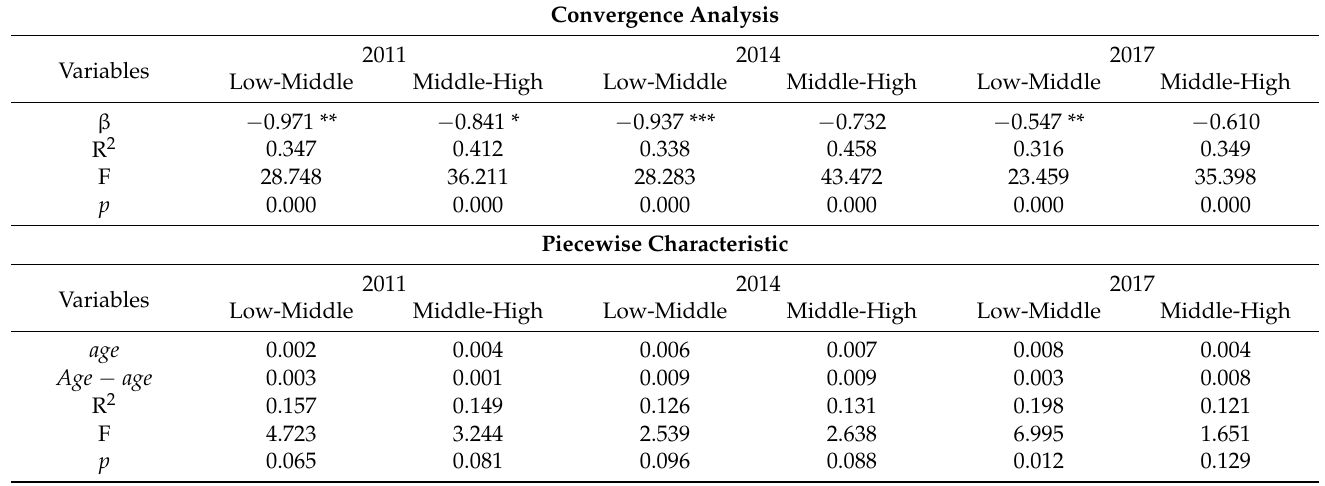
Table 5. Health difference